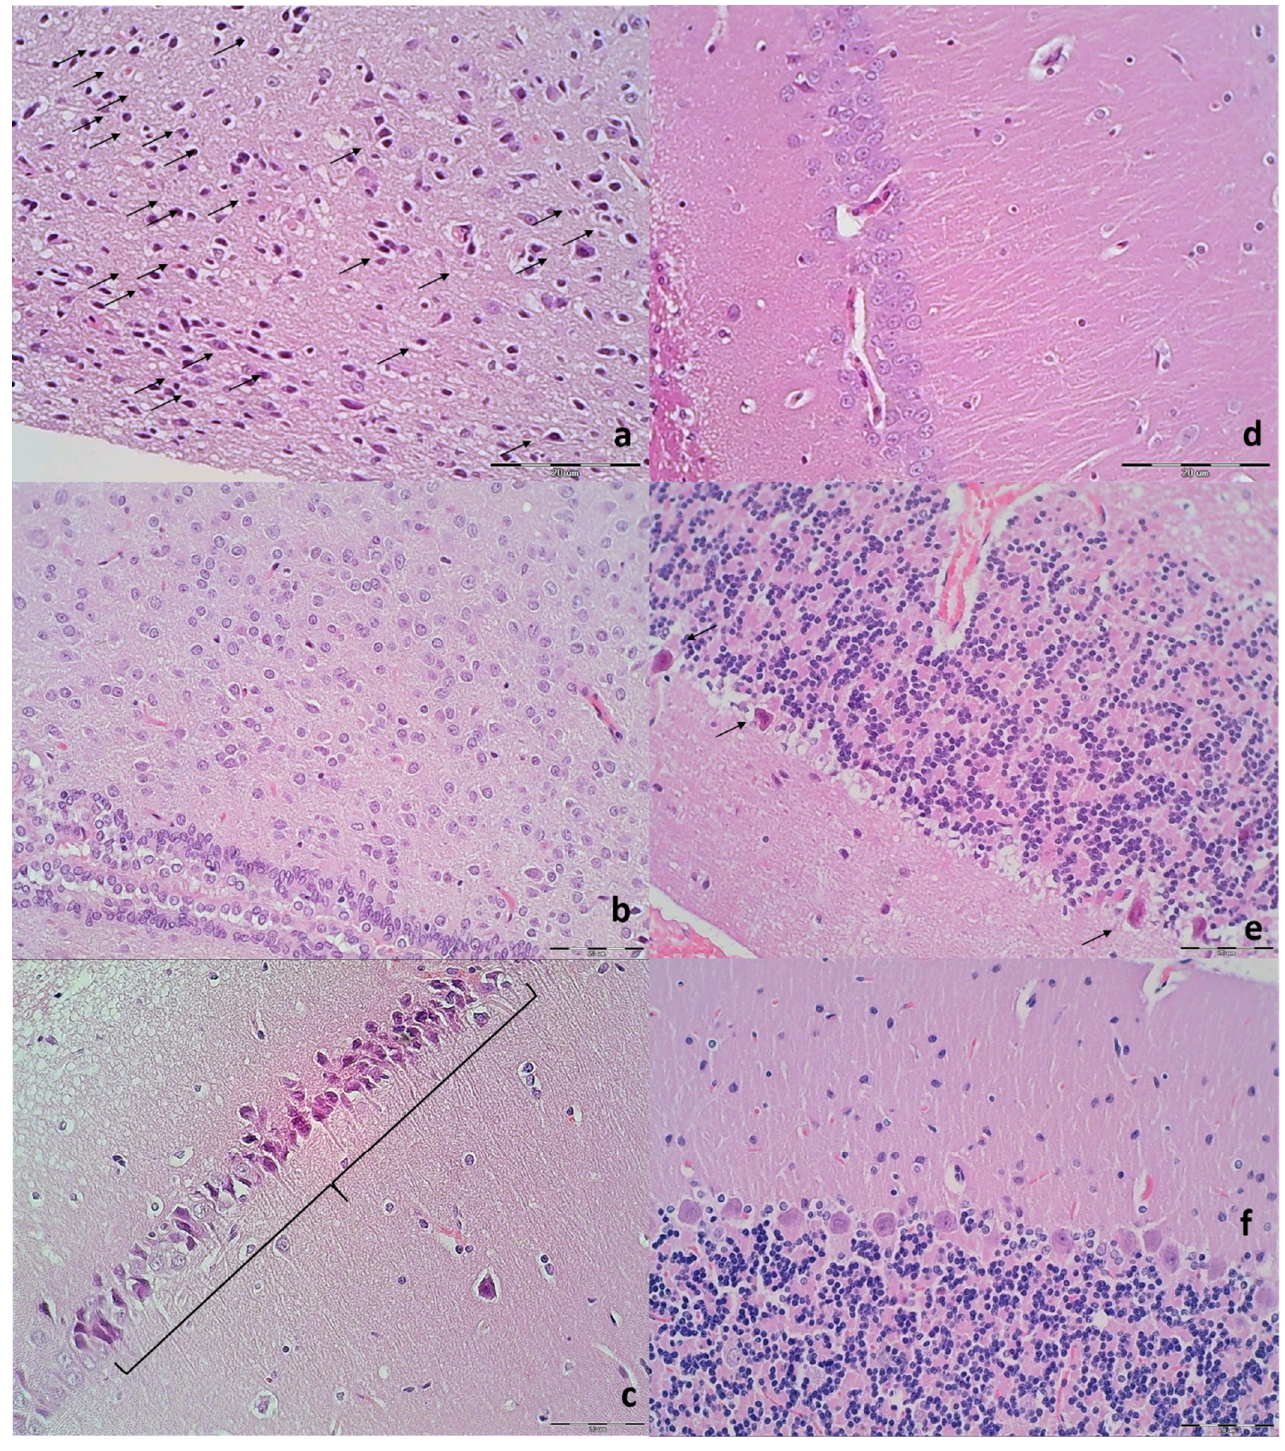
Figure 12. Illustrative neuropathologic changes in the rat cerebellar cortex, hypothalamus and hippocampus (HE staining). ( a ) Control showing marked karyopyknosis of hypothalamic neurons (arrows); ( b ) normal structure of hypothalamus in BPC 157 rats; ( c ) marked karyopyknosis of pyramidal cells of the hippocampus in control (marked with brace); ( d ) normal hippocampus in BPC 157 rats; ( e ) marked karyopyknosis, degeneration (arrows) and loss of Purkinje cells of the cerebellar cortex in control; ( f ) normal structure of cortex in BPC 157 rats. Magnification × 200 (( a – f ); scale bar 20 µ